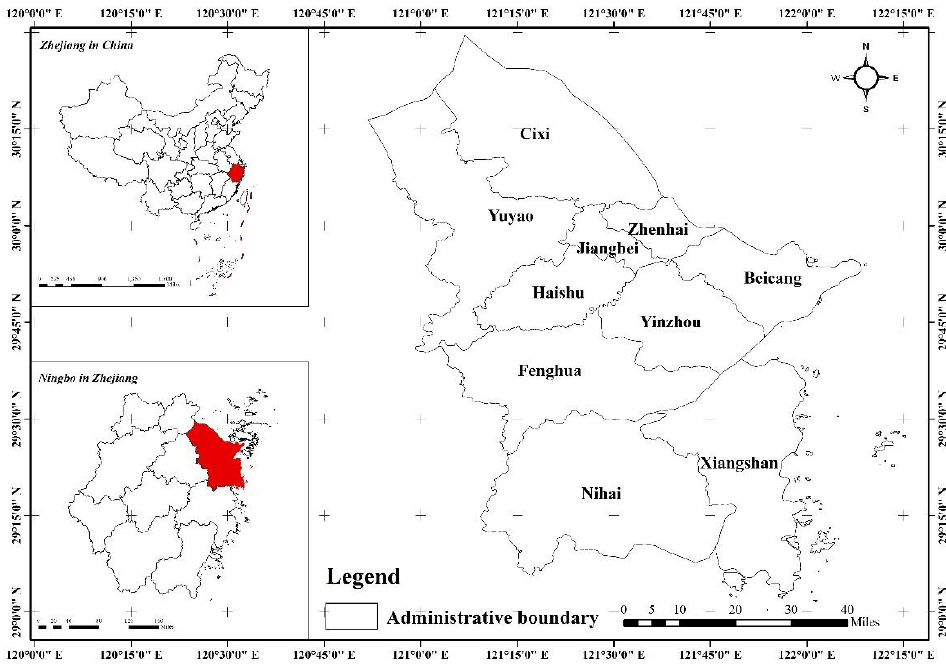
Figure 1. Location of study region in China.